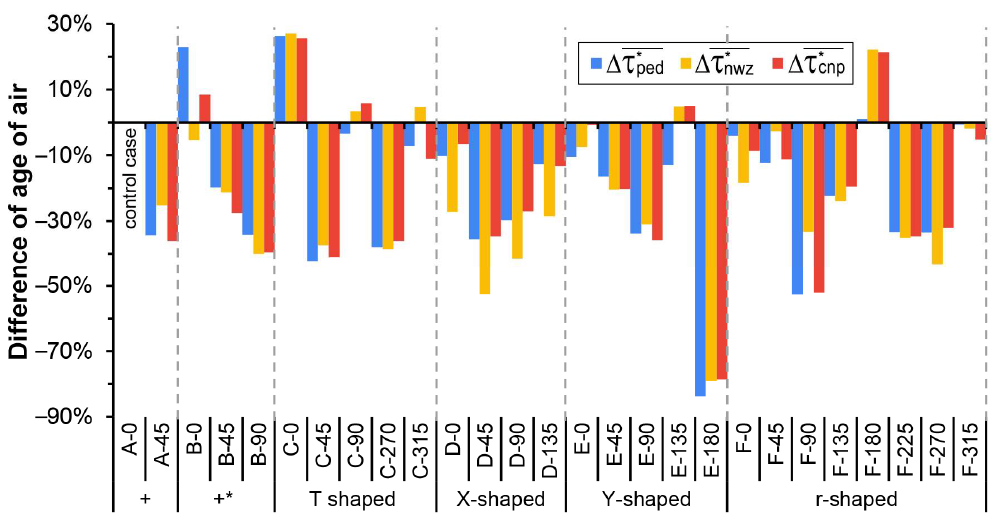
τ ∗ ) for all cases, taking Case A-0 as the control